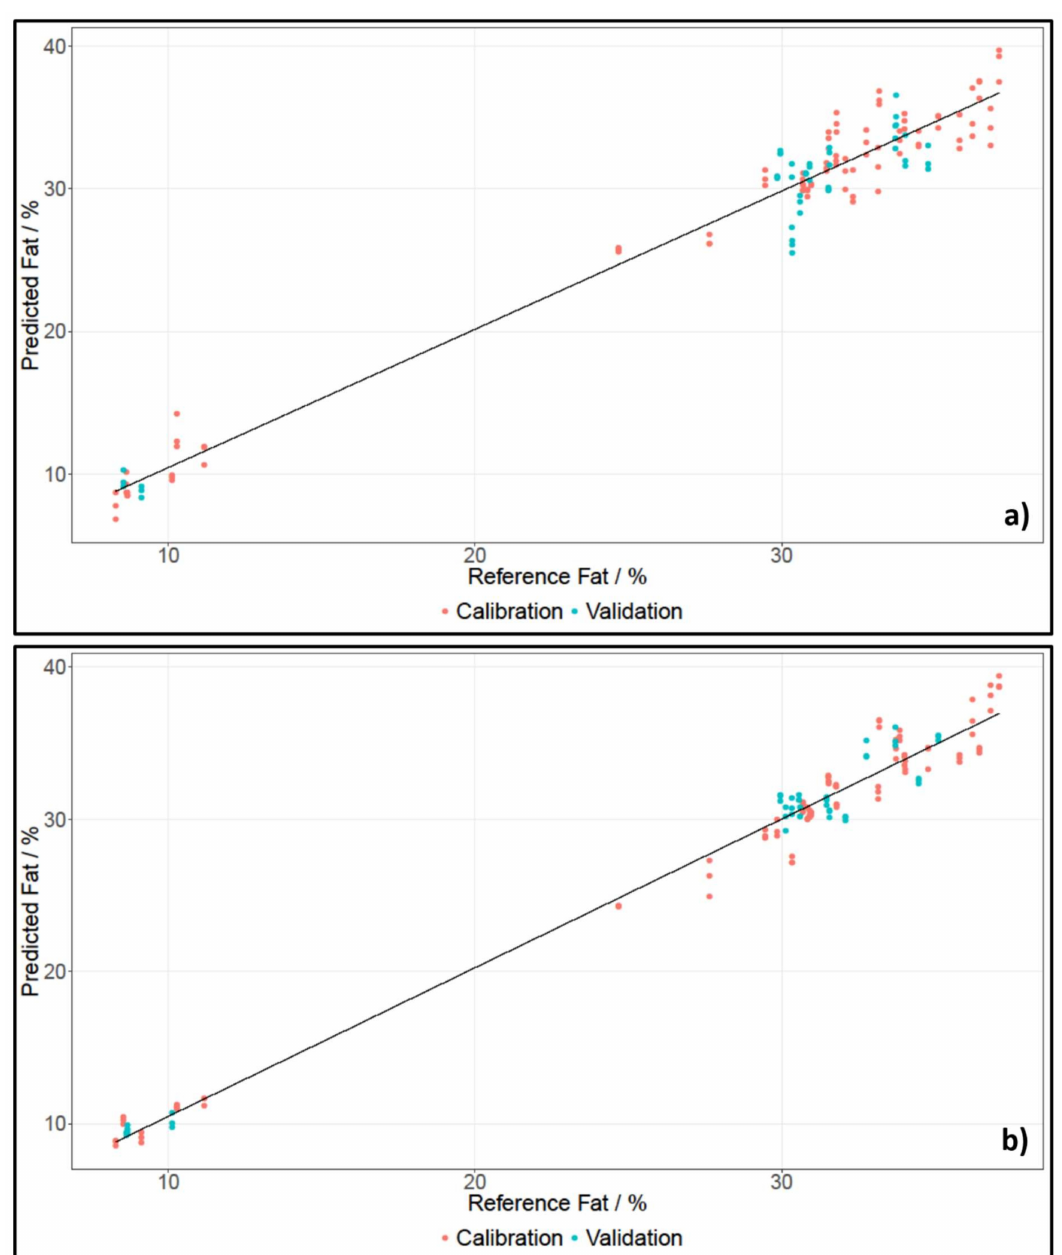
Figure 2. PLS regression of fat content of whole pieces of cheese, established using data of NIRFlex N-500 ( a ) and SCiO ( b